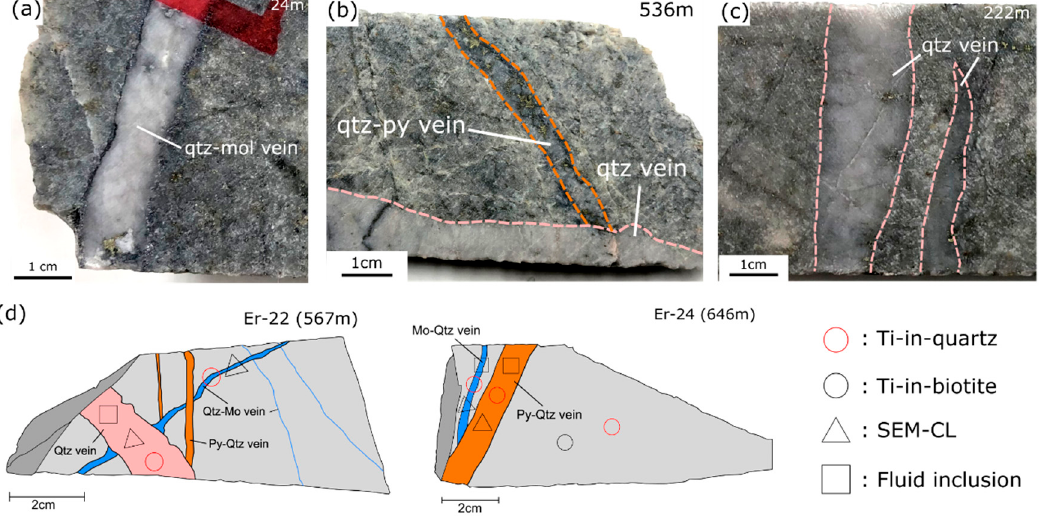
Figure 4. Photographs of the three vein types of the Erdenet deposit. ( a ) Quartz–molybdenite vein cut by later veins, ( b ) Quartz–pyrite vein cut by the later qtz vein. ( c ) Quartz vein within the quartz porphyry. ( d ) Sketch of samples showing analytical spots and crosscutting relationships among vein generations on tonalite/granodiorite porphyry.